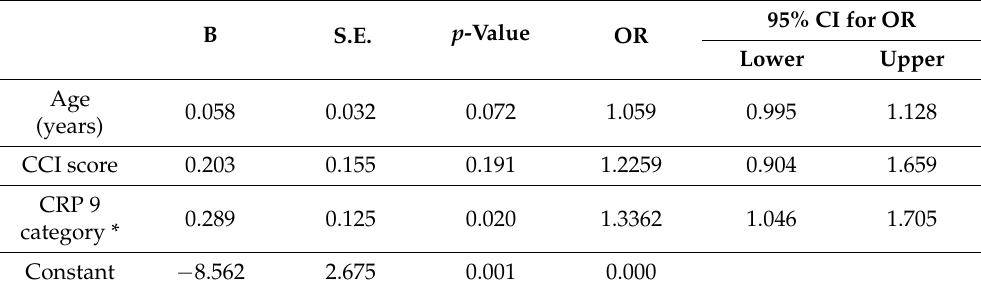
Table 6. CCI scores and CRP levels on admission in non-surviving and surviving patients’ groups with odds ratio. B S.E. p -Value